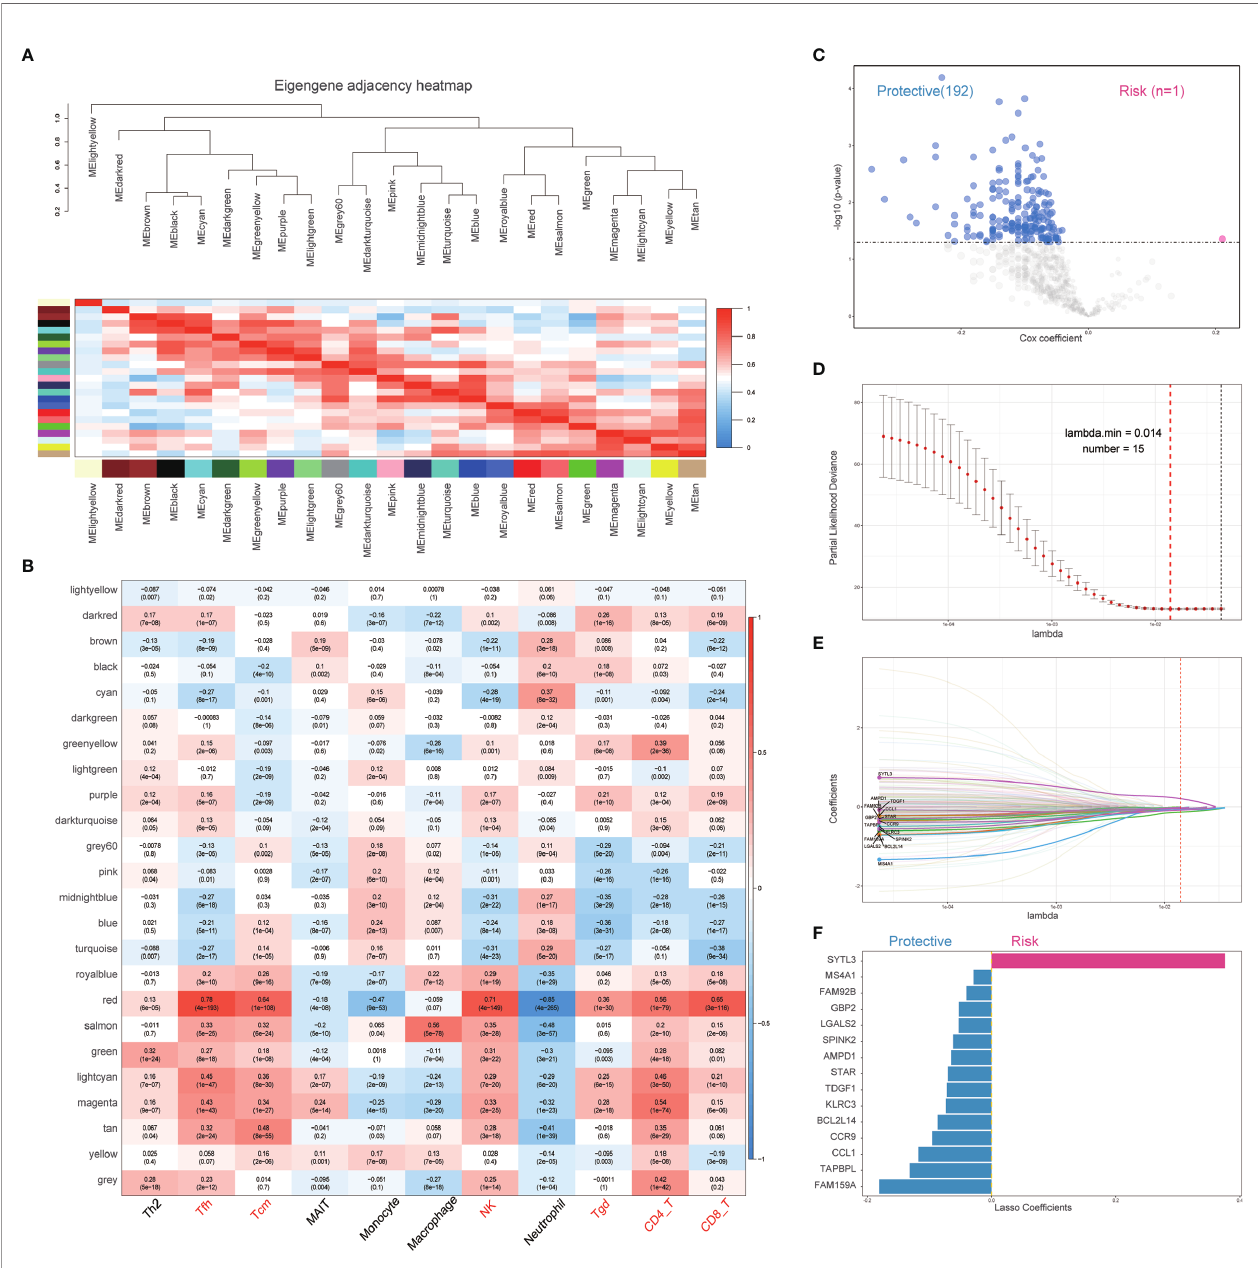
FIGURE 3 | Establishment of an immune-related gene signature with WGCNA. (A) Clustering diagram of the correlation among the 24 WGCNA modules. Correlation value is color coded. Red indicates a positive correlation, blue indicates a negative correlation, and the degree of color is proportional to the correlation. (B) Correlation heatmap between WGCNA modules and immune cell in fi ltration scores. (r values and p-values are shown; correlation values are color-coded). (C) Association between red-module genes and survival. The Cox coef fi cient and p-value of each gene are shown. Only genes with p<0.05 were considered for further analysis. A total of 193 promising candidates were identi fi ed among the hub genes extracted from the red module. Blue markers indicate prognostic protective genes, while red markers indicate the opposite. (D) The adjustment parameter (lambda) in the LASSO model was selected for 10-fold cross-validation by the minimum criterion. Partial likelihood deviation curves were plotted against lambda. Dotted vertical lines were drawn at the optimal values by using the minimum criterion and 1 standard error of the minimum criterion (1-SE criterion). (E) LASSO coef fi cient pro fi les of the 193 immune-related genes. A coef fi cient pro fi le plot was produced against the log (lambda) sequence. A vertical line was drawn at the value selected using 10-fold cross-validation, where the optimal lambda resulted in 15 nonzero coef fi cients. (F) Distribution of the LASSO coef fi cients of the 15 immune-related gene signatures. The horizontal coordinate indicates LASSO coef fi cients, genes with negative coef fi cients in this regression indicate prognostic protective genes (blue marker), and positive numbers indicate poor prognostic genes (red marker). LASSO, least absolute shrinkage and selection operator; WGCNA, weighted gene coexpression network